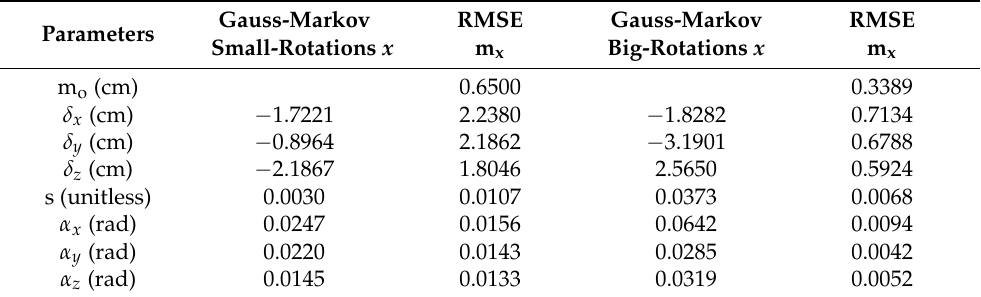
Table 2. Aristotle sculpture: transformation parameters ( x ) with their RMSE ( m x ) in coarse registra- tion with the LSP+PFH method.